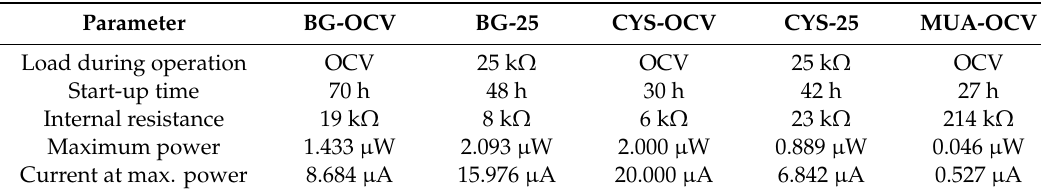
Table 3. Performance µ MFC